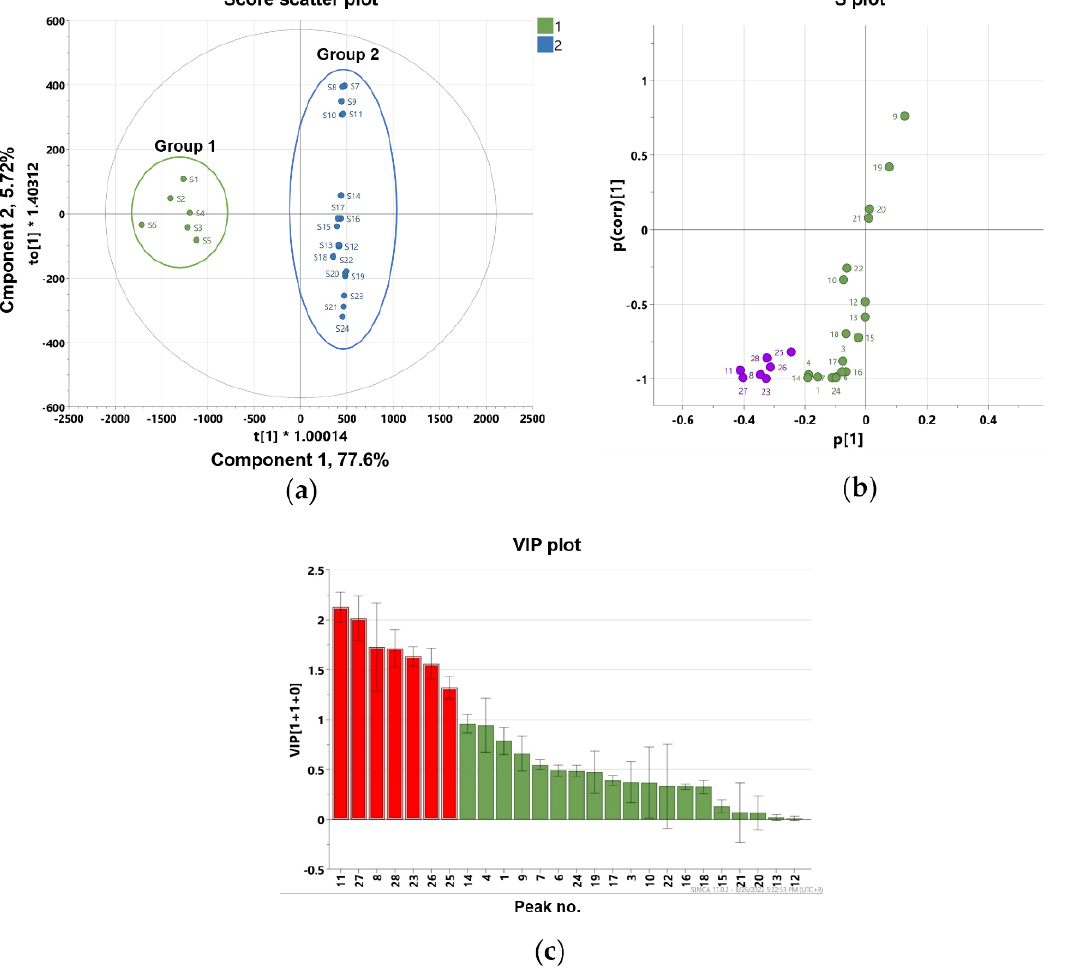
Figure 5. Orthogonal partial least square-discriminant analysis ( a ) score plot and ( b ) S-plot exhibit markers for differentiating flower and root, stem, and leaf parts of P. japonicum (purple color shows the most deviated variables from the center), ( c ) the variable importance for the projection plot (VIP-plot) scores of the selected markers (red color shows the variables with VIP values ≥ 1).